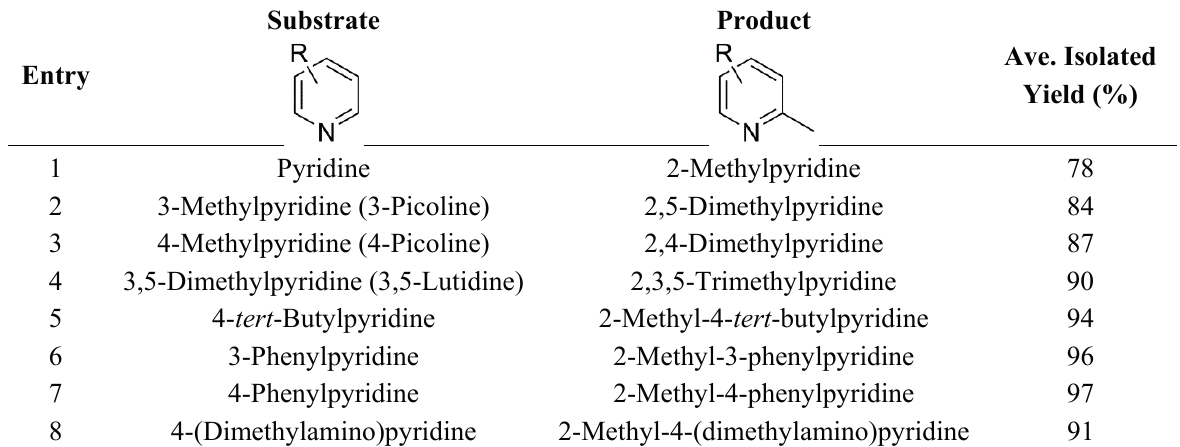
Table 1. α -Methylation of substituted